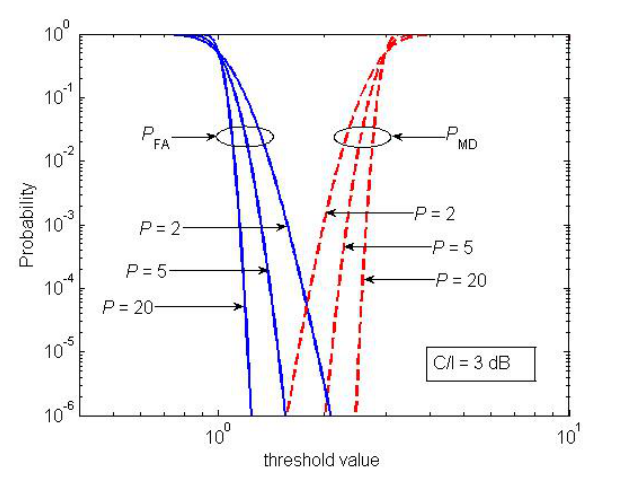
Figure 15. Detection performance ( N = 1 , 024 , C/I = 3 dB